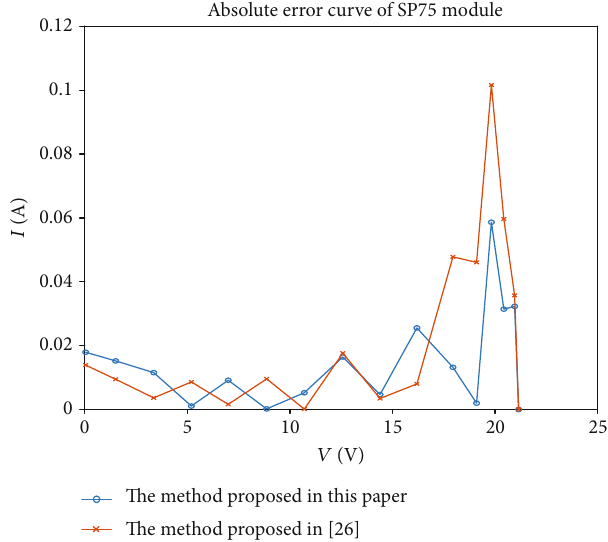
Figure 10: Absolute error comparison of SP75 modules with di ff erent extraction methods under STC.